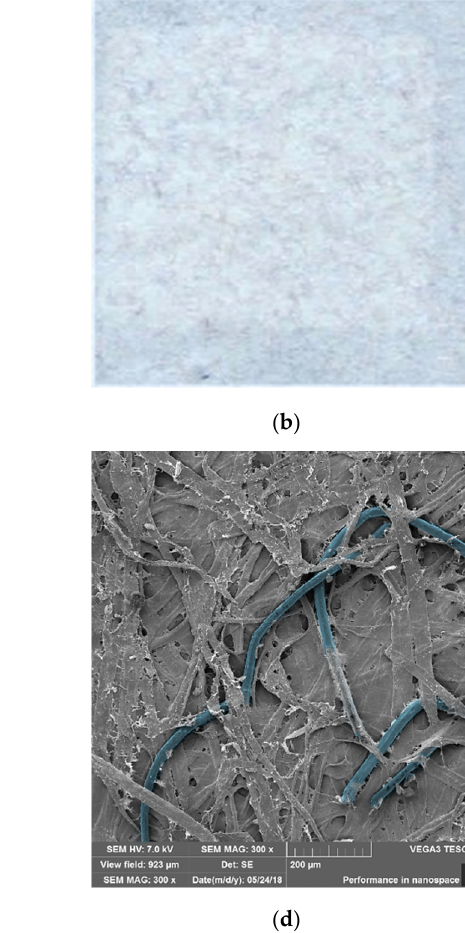
Figure 7. Paper samples doped with 20% of PAN–PDA fibres made of unrefined: ( a , c ) and refined: ( b , d ) cellulose pulp. Top row: photography of samples with × 10 magnification. Bottom row: SEM images of the same samples with × 300 magnification, inside scale 200 µ m. The images show the doped paper after UVC irradiation at 5 J/cm 2 .